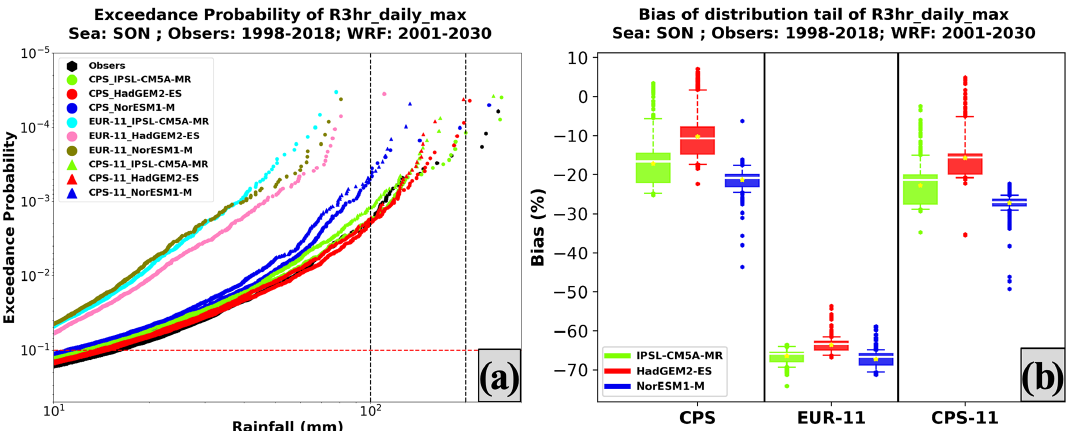
Figure 5. Exceedance probability distribution (a) for daily maximum 3h rainfall in the autumn from in situ observations (1998–2018) and all simulations (2001–2030). The bias (b) of 10% in the tail of the distribution from each simulation against in situ observations. The red dotted line in panel (a) denotes the exceedance probability of 0.1, above which the simulated rainfall values are used to estimate the bias of the distribution tail in panel (b)